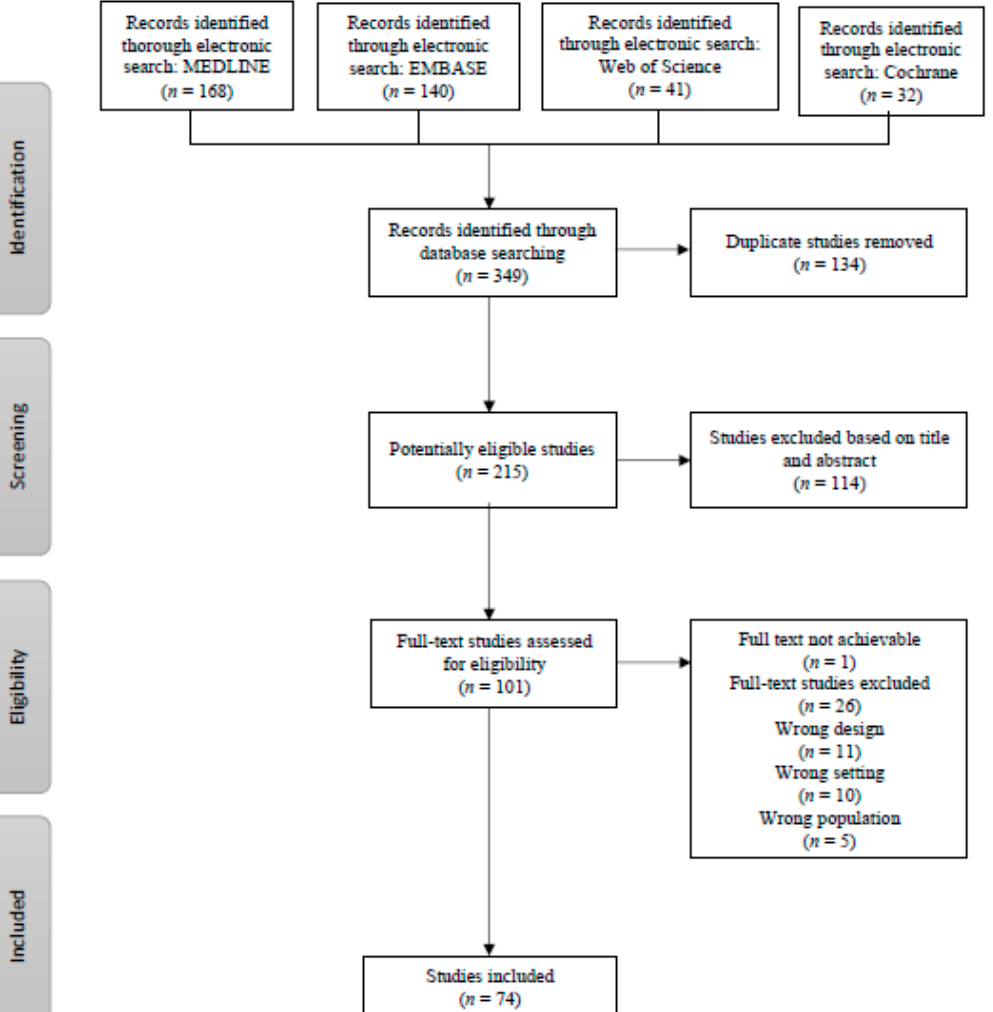
Figure 1. Flow chart of the search and selection process. Table 1. Study demographics of the 74 included papers.